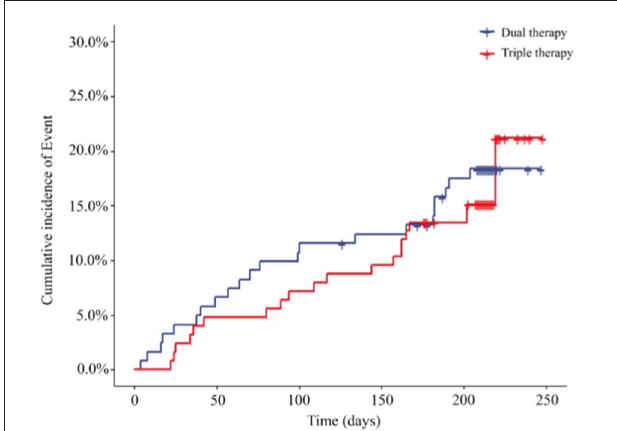
FIGURE 5 | Incidence of cardiovascular event outcomes of the two groups (PPS, N = 247) (HR, 0.844; 95% CI, 0.461 to 1.547; P = 0.5836). HR, hazard ratio. Dual therapy: ticagrelor therapy group; triple therapy: clopidogrel plus aspirin